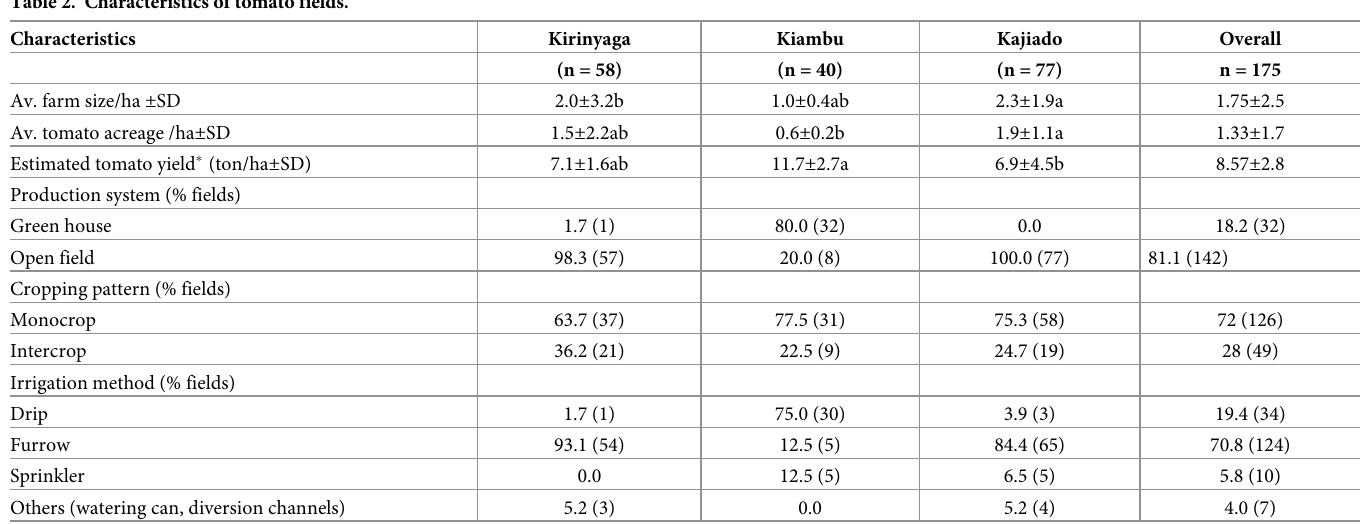
Table 2. Characteristics of tomato fields.